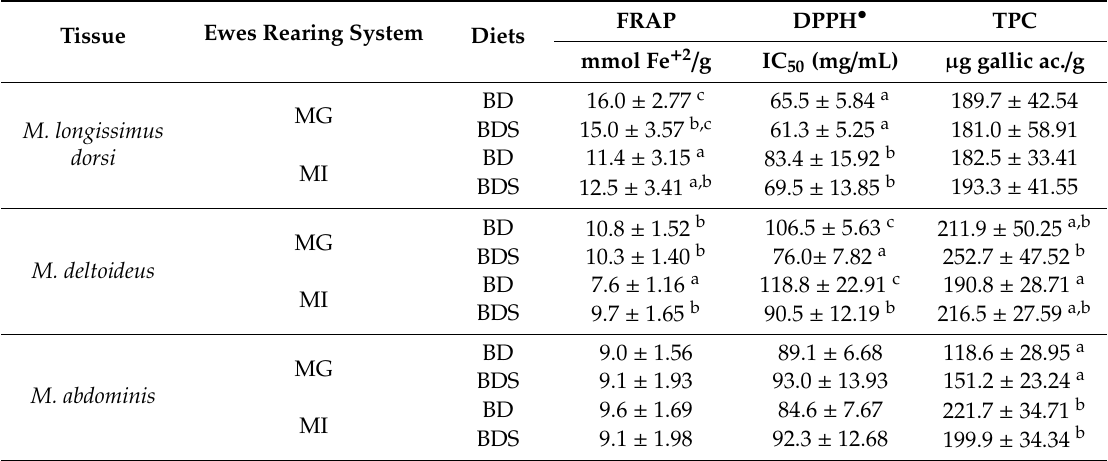
Table 8. Antioxidant status of lamb